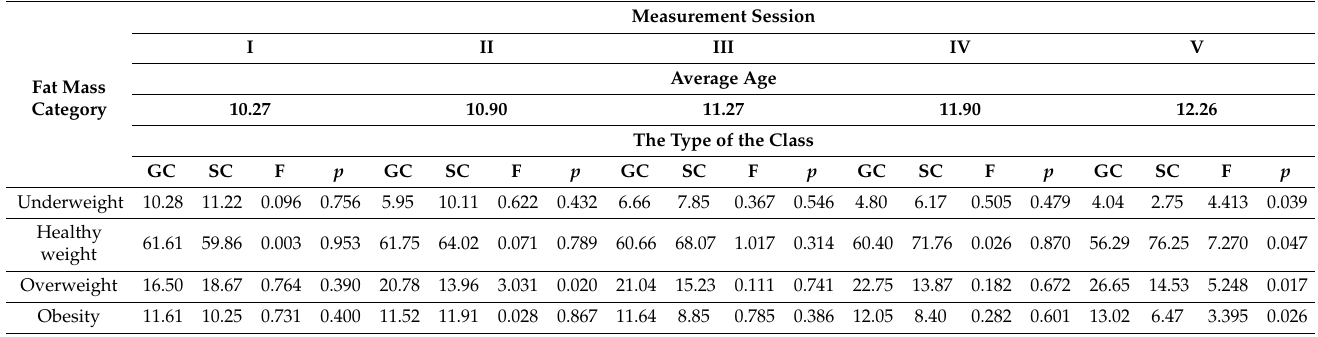
Table 2. The percentage of fat mass categories in the GC and SC children during the course of the study.